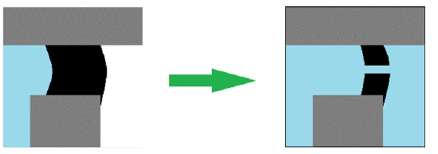
Figure 4. The process of wastage of the magnetic fluid film during a long period.